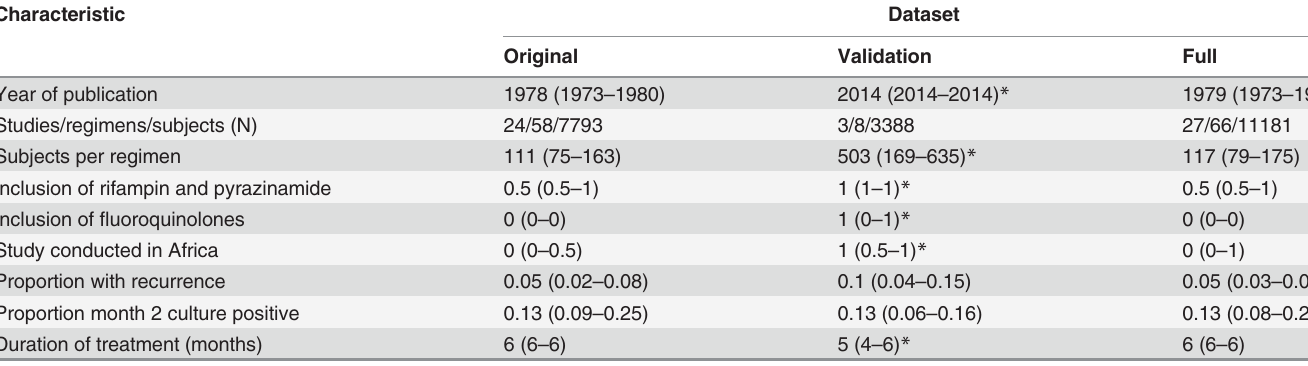
Table 1. Characteristics of regimens included in the original (training), validation, and full dataset.